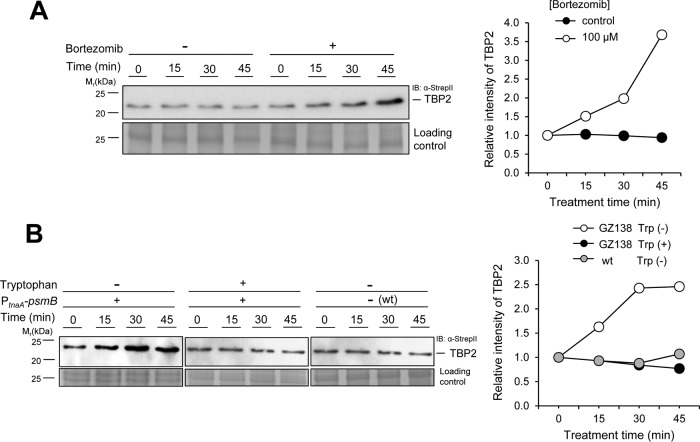
The abundance of TBP2 is increased by inhibition of 20S proteasomes. (A) Abundance of TBP2 in wild-type (wt) cells treated with an inhibitor of proteasomal CPs (bortezomib, +) or a mock control (dimethylformamide [DMF], −). (B) Right, TBP2 abundance in GZ138 (PtnaA-psmB) cells grown in medium containing or lacking tryptophan, as well as wt cells grown in medium lacking tryptophan, for the indicated times. Quantification of relative TBP2 protein levels is expressed as fold change from time zero, which was set at 1.0. Left, TBP2-StrepII was coexpressed with Flag-SAMP2 and monitored by anti-StrepII antibody IB. Equal loading was confirmed by CB staining. Experiments were performed in at least biological duplicates, and representative images are shown. Data were quantified by ImageJ. See Materials and Methods for details.